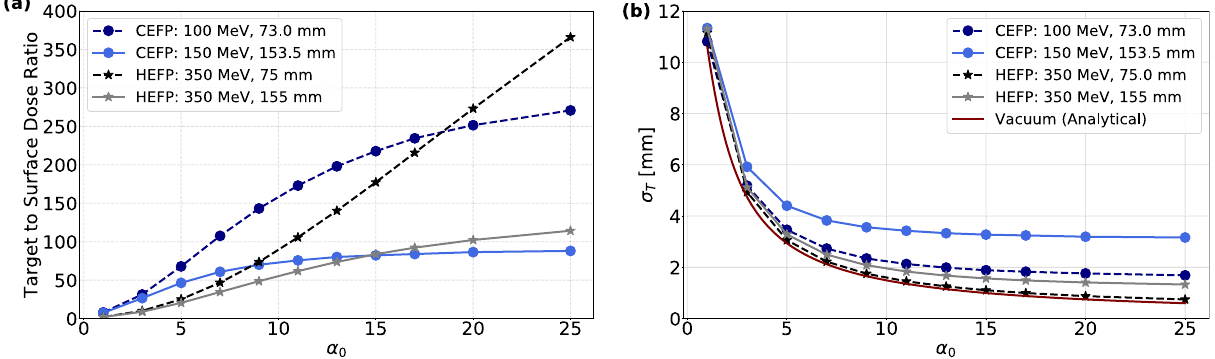
Figure 7. ( a ) TSDR and ( b ) σ T as a function of focusing strength α 0 , for two different depths. The beam sizes is also compared with the beam size without scattering expected from Eq. (1).